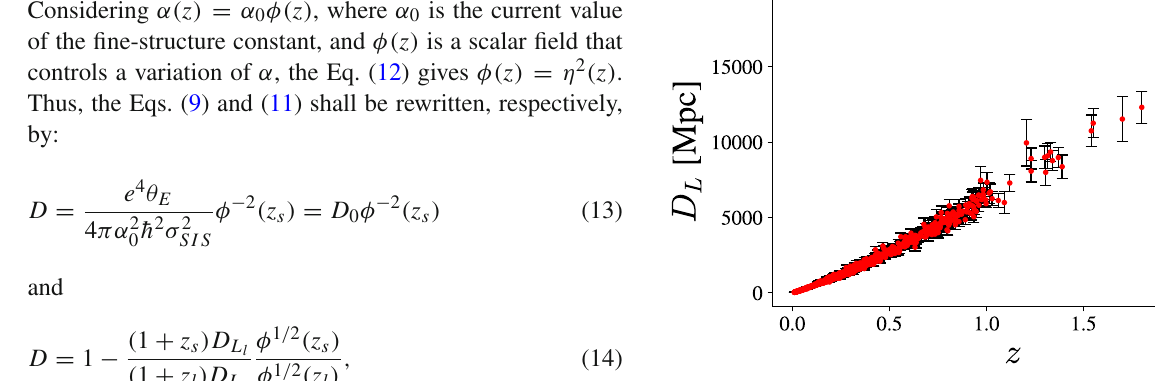
Fig. 1 Luminosity distances of spectroscopically confirmed SNe Ia from Pantheon compilation. Such a sample is constructed from the apparent magnitude ( m b ) of Pantheon catalog by considering M b = − 19 . 23 ± 0 . 04 (absolute